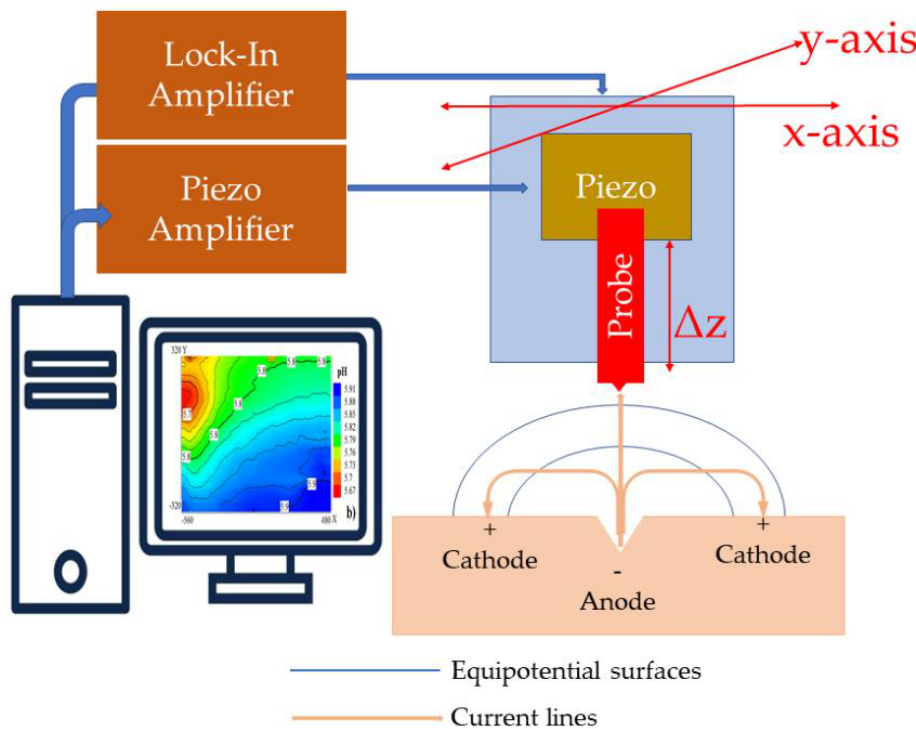
Figure 11. SVET set up showing a typical measurement across the x – y axis.